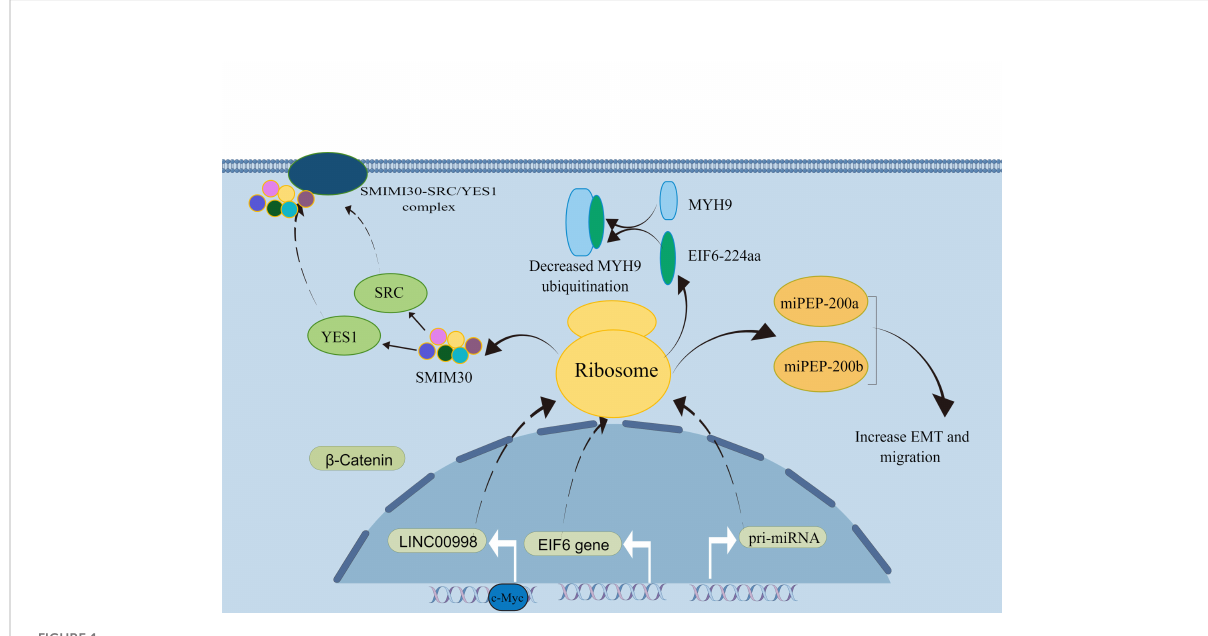
FIGURE 1 Role of ncRNAs-encoded peptides/protein in cancers. (By